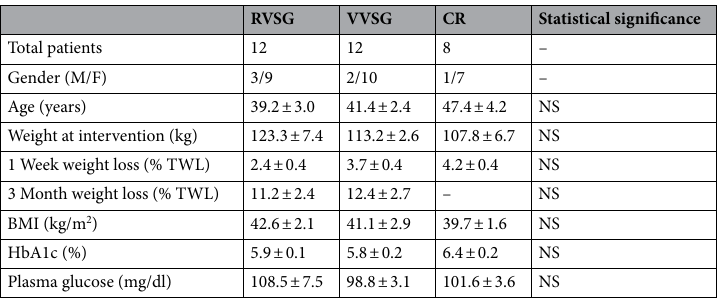
Table 1. Demographics of subjects undergoing routine VSG (RVSG), VSG with IV Vancomycin (VVSG) or caloric restriction (CR). Values represent mean ± SEM. TWL total weight loss, NS not